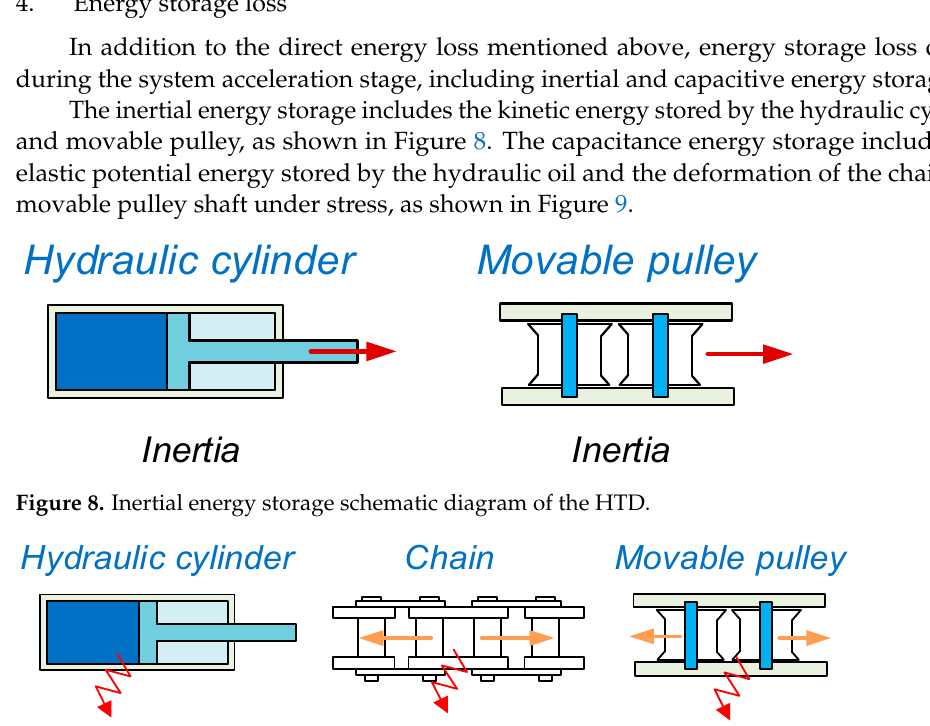
Figure 7. Leakage loss schematic diagram of the HTD.